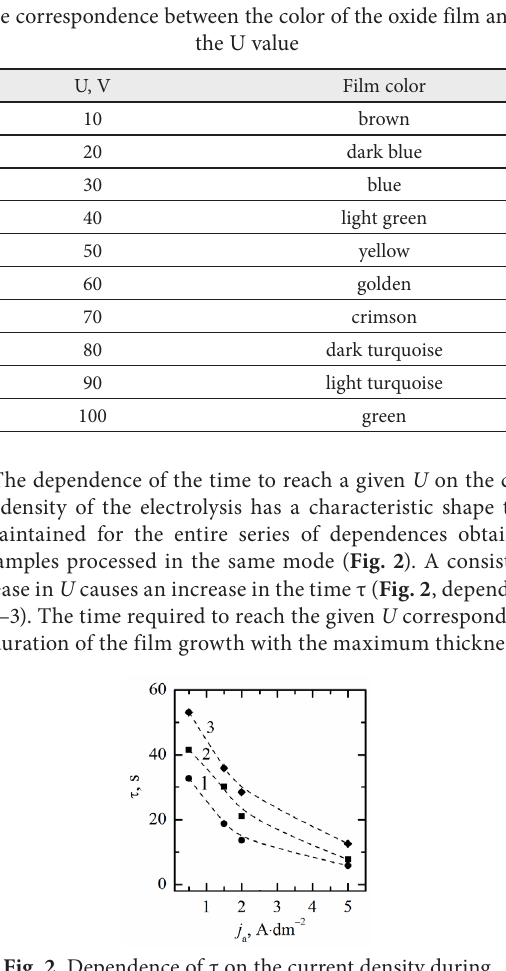
Fig. 2. Dependence of τ on the current density during the oxidation of the Ti6Al4V alloy. U, V: 40(1); 60(2); 80(3).